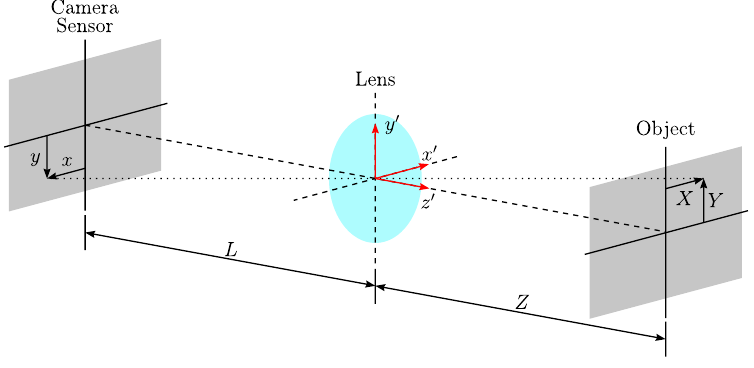
Figure 1. A 3D depiction of the pinhole imaging model